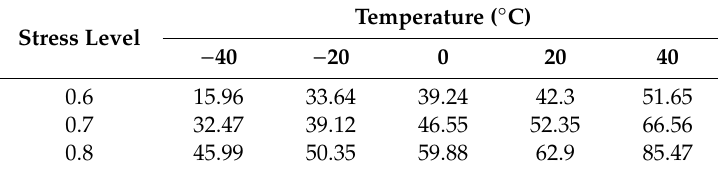
Table 13. The average value of ρ p c at di ff erent ambient temperatures and stress levels ( Ω ·